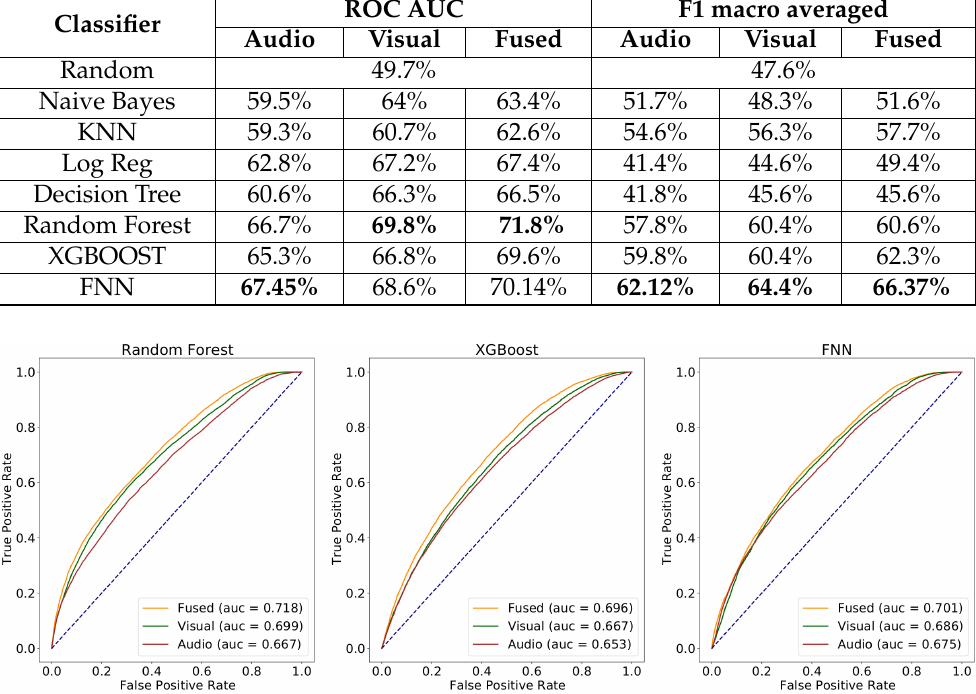
Figure 6. Receiver Operating Characteristic (ROC) curve of the Random Forest classifier ( left ), XGBoost classifier ( middle ), Fully Connected classifier ( right ).